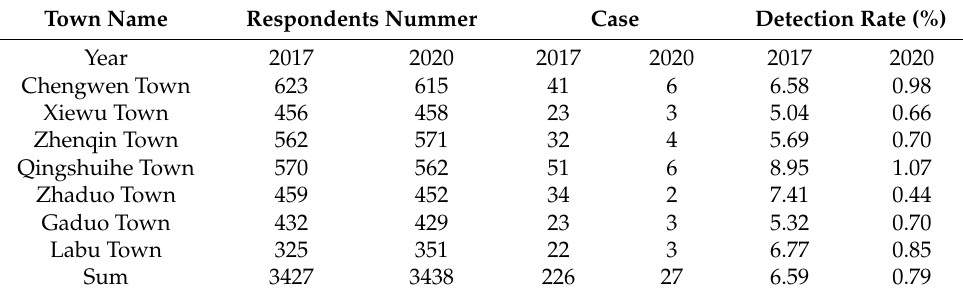
Table 1. The descriptive statistical results of the main variables are shown in Table 2. Table 1. The detection rates of Hydatid disease of the respondents in each town. Town Name Respondents Nummer Case